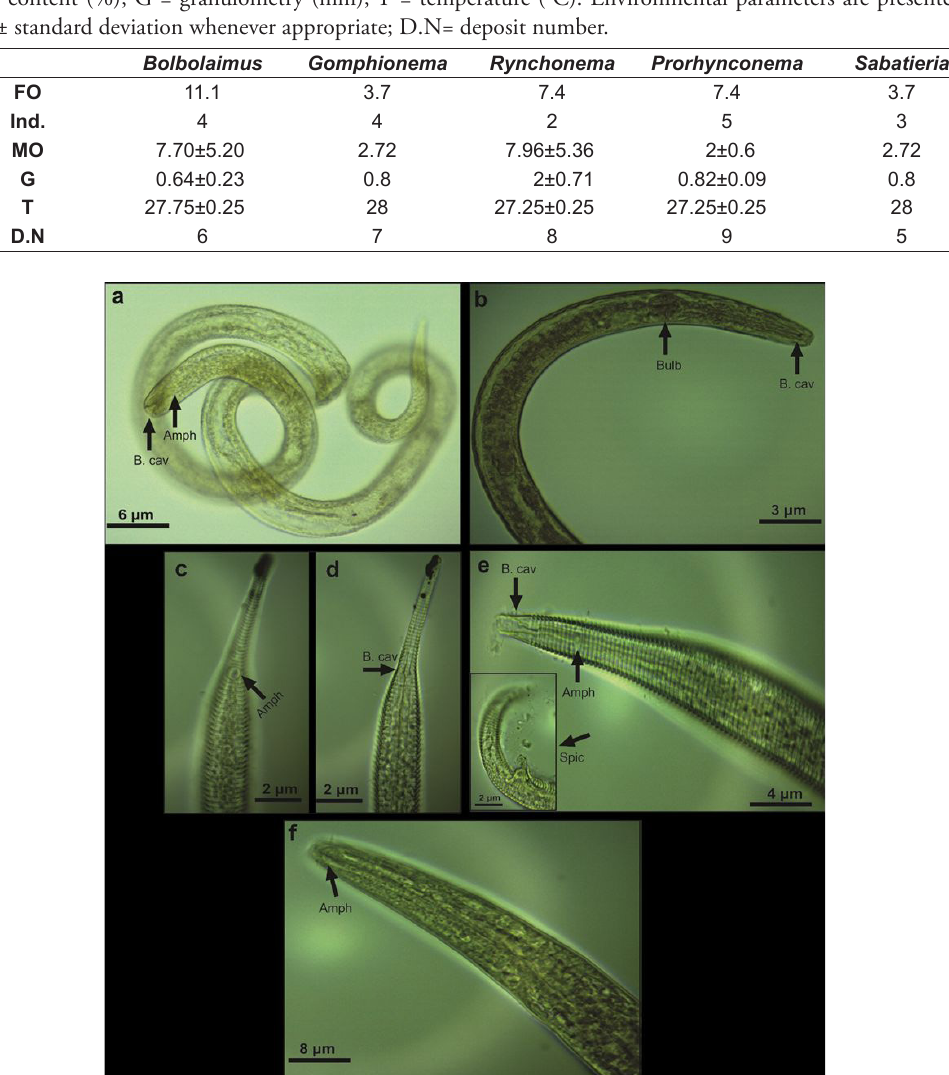
Figure 1. Free-Living Nematode genera in the Semi-Arid region. a= Bolbolaimus, b= Gomphionema , c-d =Rynchonema, e =Prorynchonema, f = Sabatieria. Amp= Amphidio; B. cav= Buccal Cavity; Bulb= Shape of pharyngeal bulb; Spic=